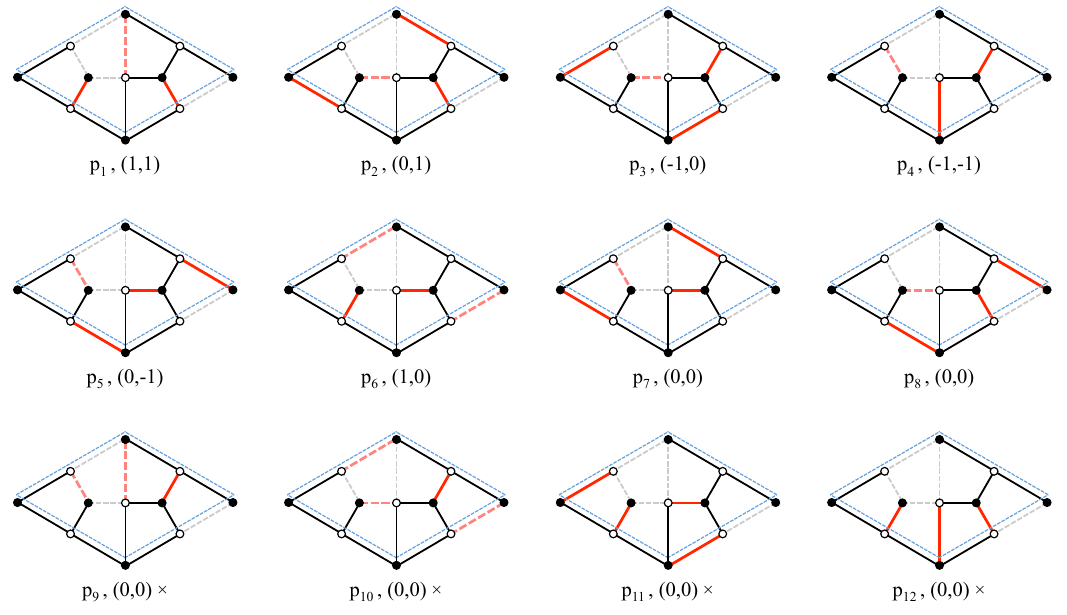
Figure 28. The 12 perfect matchings for phase 1 of dP 3